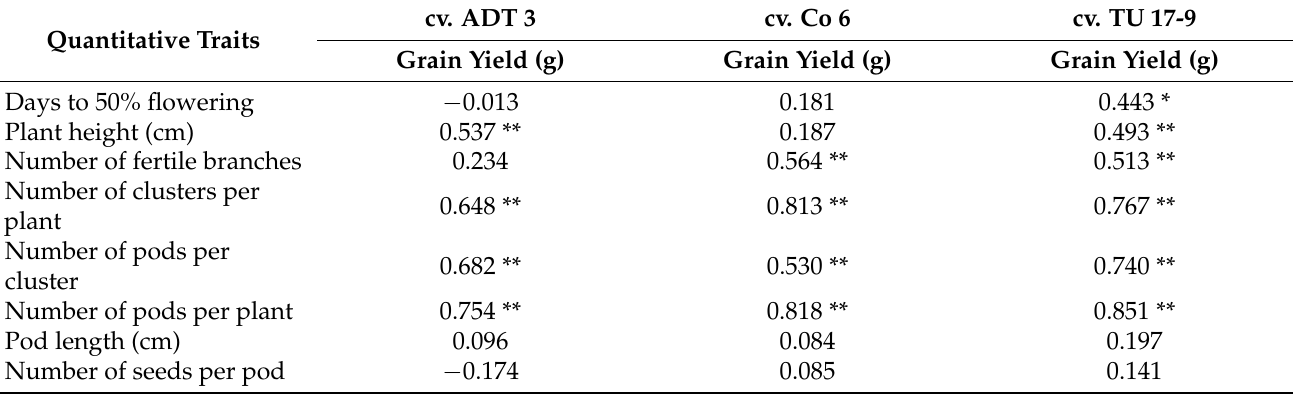
* and ** indicates significance at 5% and 1%